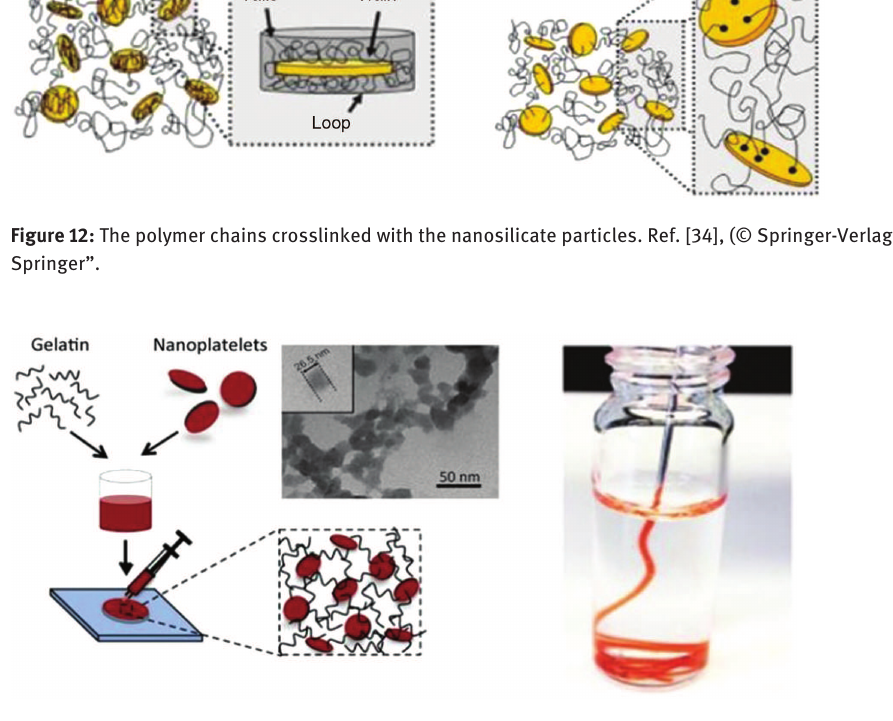
Figure 13: The scheme showing the preparation of the nanocomposite gels and injection of nanocomposite hydrogel through a surgical needle. The TEM image shows the size of the silicate nanoparticle. This is an unoflcial adaptation of Ref. [38] that appeared in an ACS publication. ACS has not endorsed the content of this adaptation or the context of its